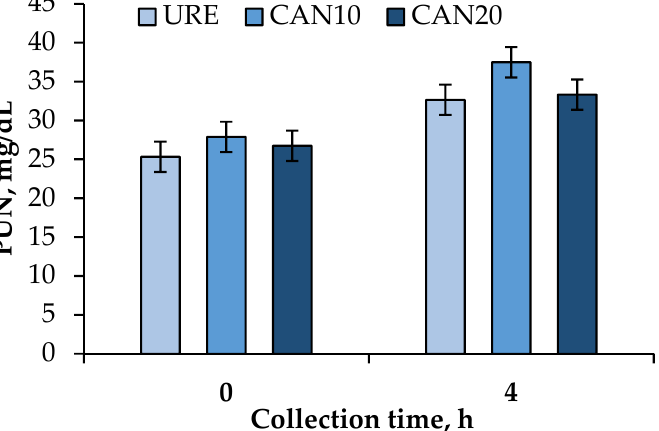
Figure 2. Effects of calcium-ammonium nitrate (CAN) fed to lactating dairy goats on plasma urea nitrogen (PUN) before (0 h) and after (4 h) the morning feeding ( p -value: treatment = 0.07; time = 0.01; treatment × time = 0.37; SEM = 1.959).